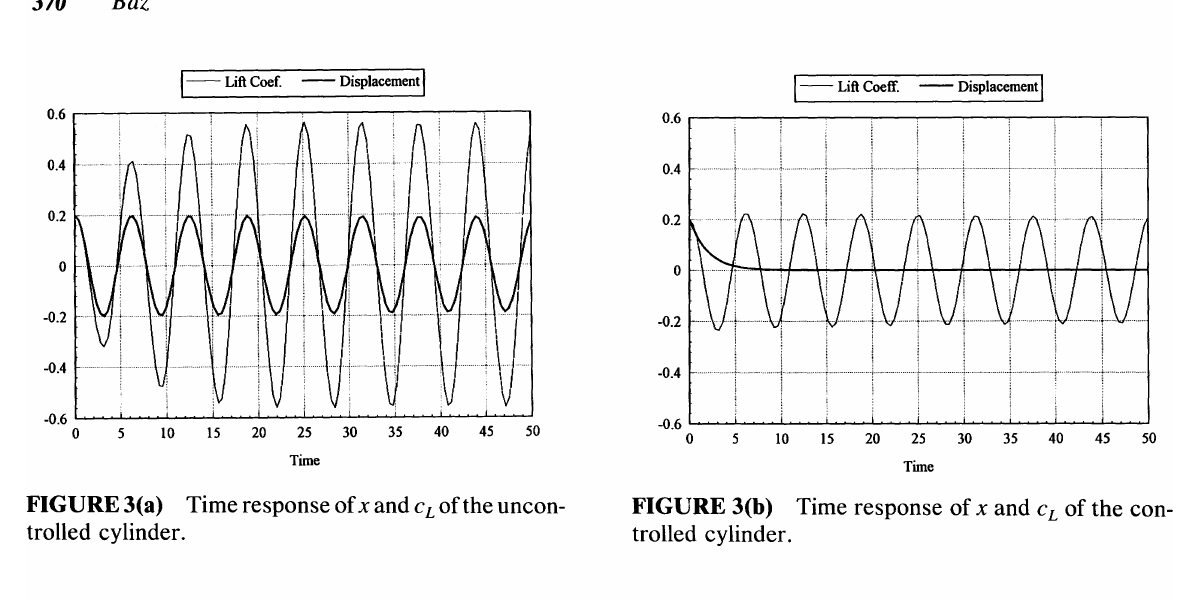
FIGURE 3(b) Time response of x and CL of the con trolled cylinder.